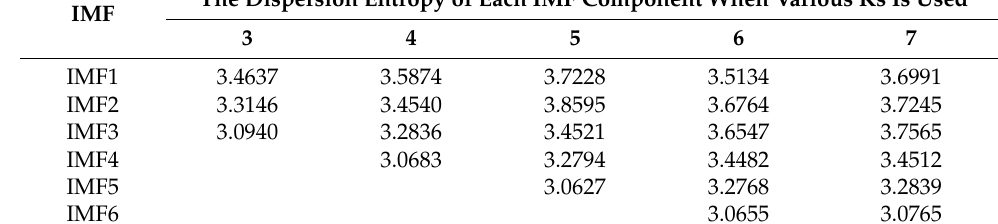
IMF Table 3. The analysis of the dispersion entropy for each component of the VMD decomposition. The Dispersion Entropy of Each IMF Component When Various Ks Is Used IMF